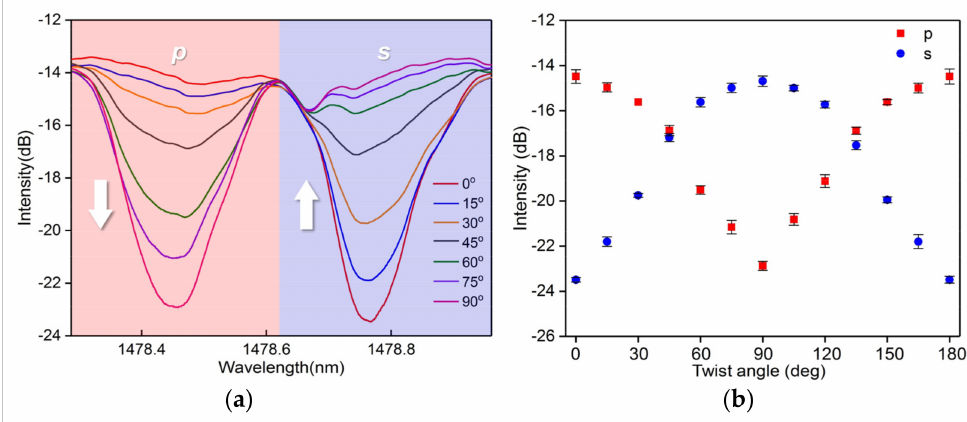
Figure 6. ( a ) spectral response to the fiber twist around 1478.6 nm; ( b ) intensity variation of p- and s-polarized